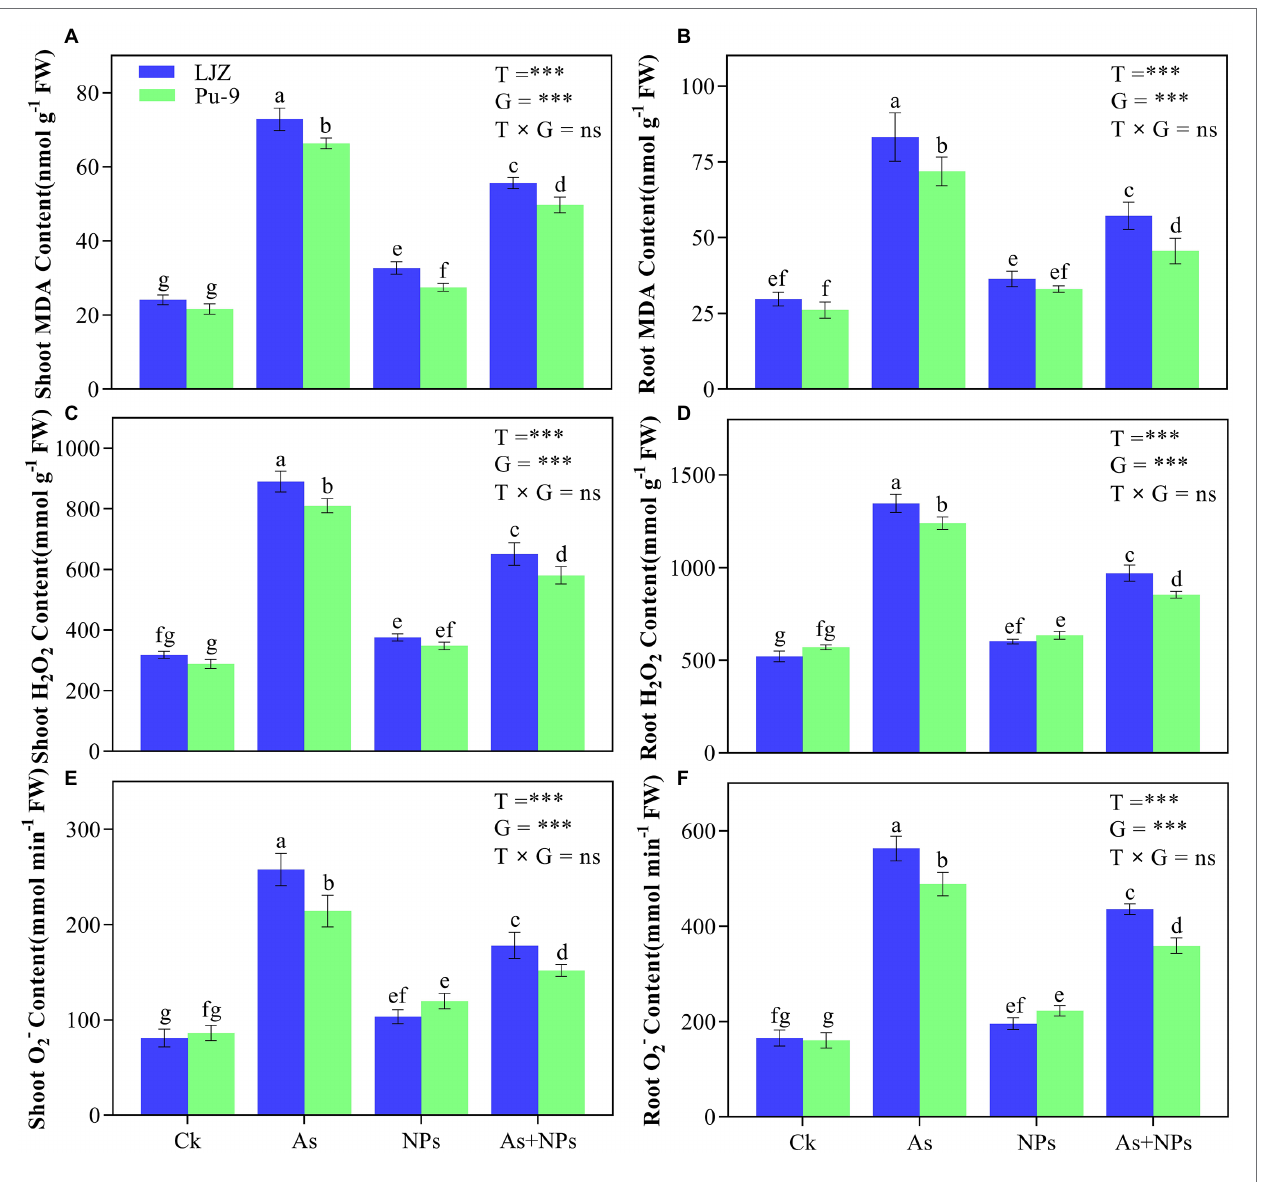
FIGURE 3 | Effects of the different treatments on MDA and ROS (H 2 O 2 and - O • 2 content in shoots and roots. Vertical bars represent the mean ± SD of four replicates. Different letters above error bars indicate the significant difference between treatments and genotypes at p ≤ 0.05. T, treatment; G, genotype; T × G, the interaction between treatment and